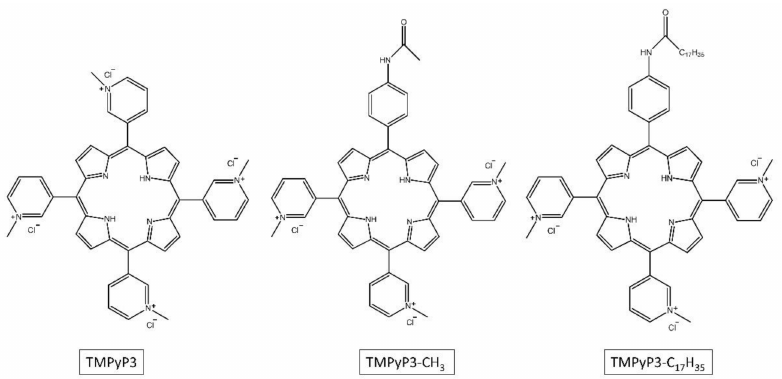
Figure 1. Structures of photosensitizers TMPyP3, TMPyP3-CH 3 , and TMPyP3-C 17 H 35